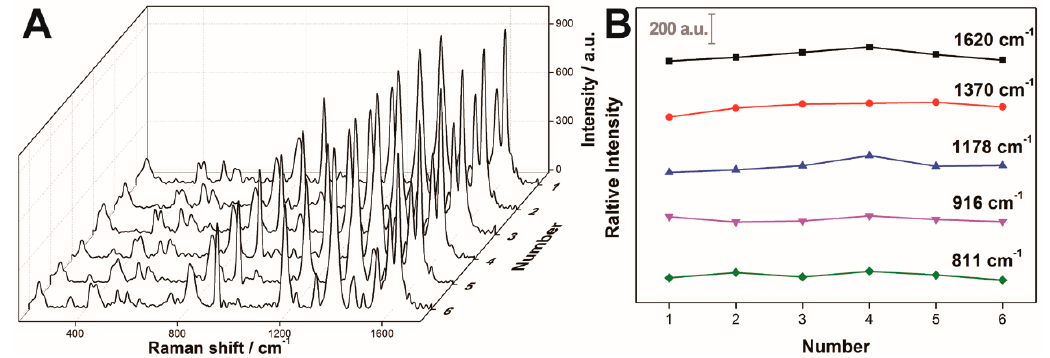
Figure 4. SERS spectra of CV induced by Au NPs@MoS 2 QDs at six randomly selected positions ( A ); Uniformities of the SERS intensities of five characteristic Raman bands on the basis of the SERS detection of the six samples ( B ).